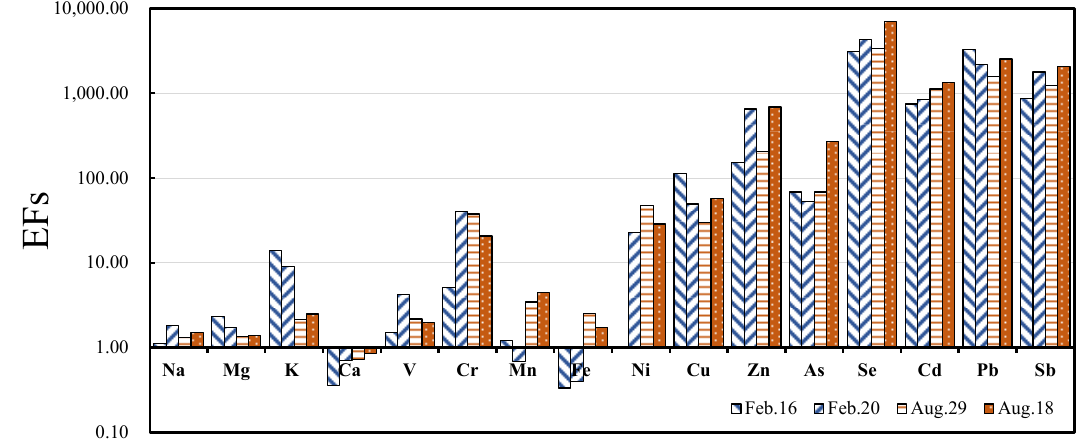
Figure 4. Enrichment factor (EF) values of each element in Fine particulate matter (PM 2.5) in four typical pollution cases.